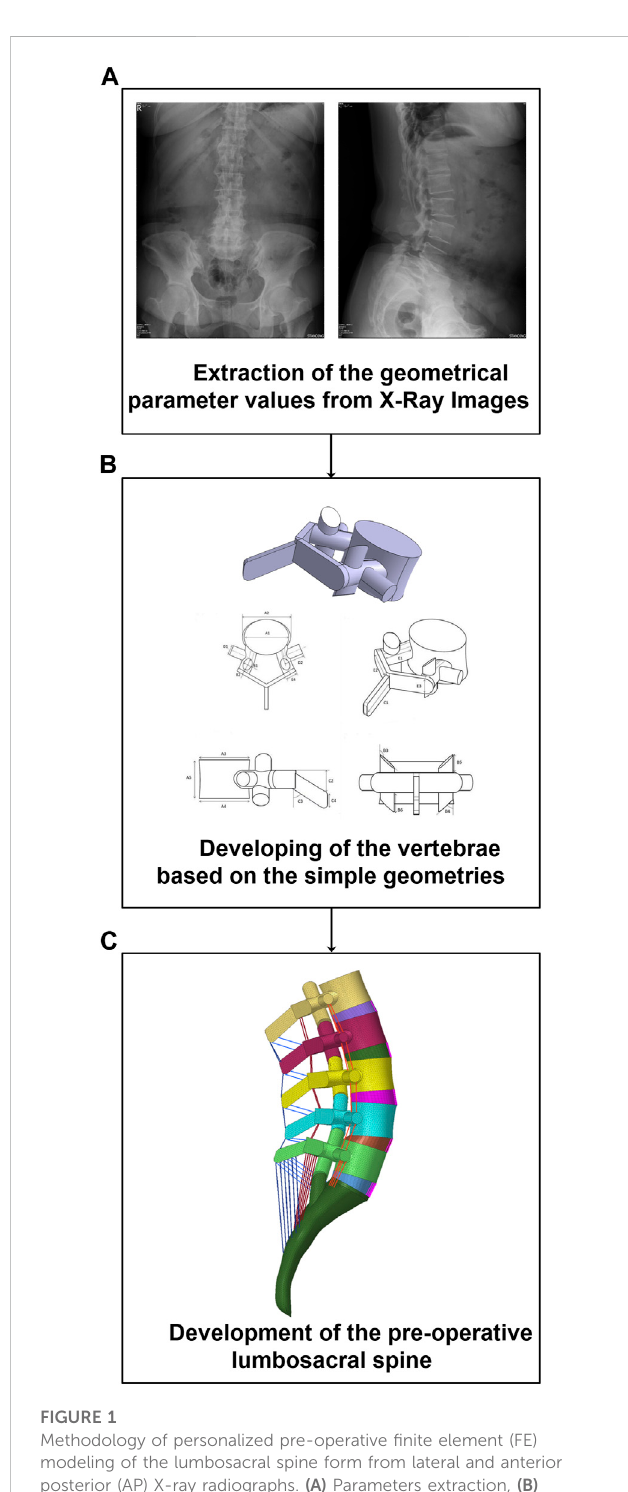
FIGURE 1 Methodology of personalized pre-operative fi nite element (FE) modeling of the lumbosacral spine form from lateral and anterior posterior (AP) X-ray radiographs. (A) Parameters extraction, (B) Development of the vertebrae, (C) Development of the FE